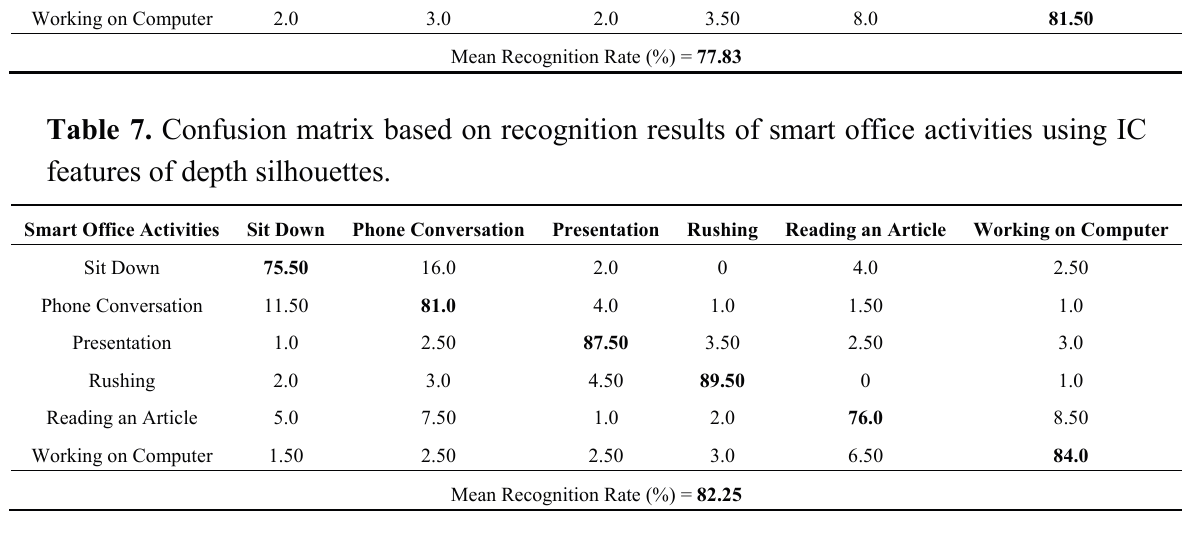
Table 8. Confusion matrix based on recognition results of smart office activities using the proposed motion features of depth